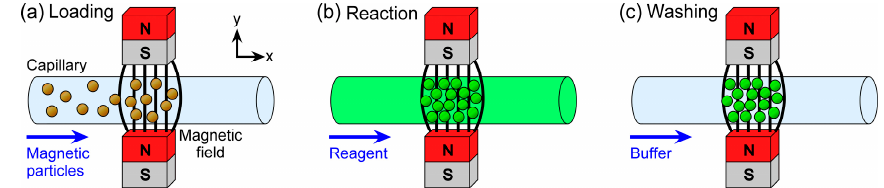
Figure 1. Principle of magnetic particle plug-based assays: ( a ) functionalised magnetic particles are introduced into a microchannel and trapped between two magnets, forming a plug; ( b ) a fluorescently labelled reagent or sample solution is flushed over the particle plug, with the reagent or target analyte binding to the particles; and ( c ) the microchannel is washed with buffer solution, allowing fluorescence detection of the trapped particle